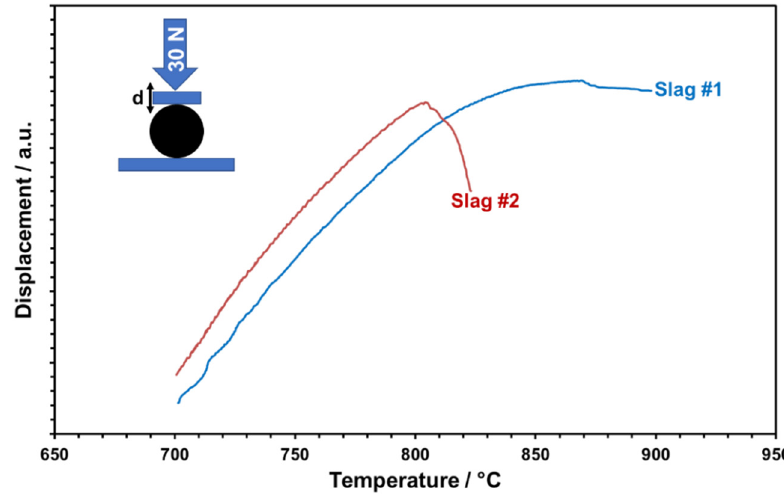
Figure 15. Temperature-dependent deformation behavior of slags under controlled uniaxial forces.